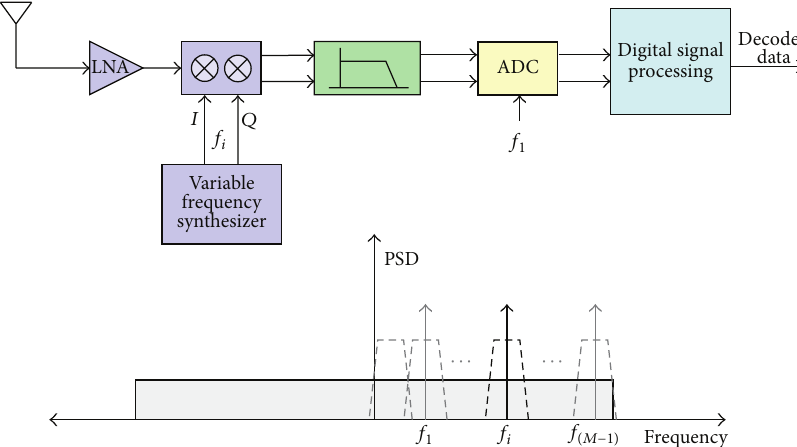
Figure 2: A narrowband, wide-tuning scanning approach for signal sensing.